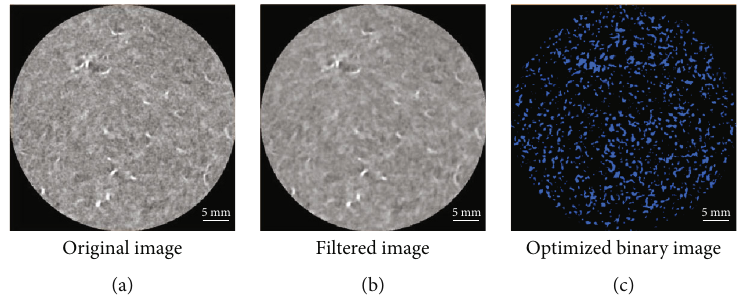
Figure 4: Images of specimen A after 60 F-T cycles. (a) Original image. (b) Filtered image (c) Optimized binary image.